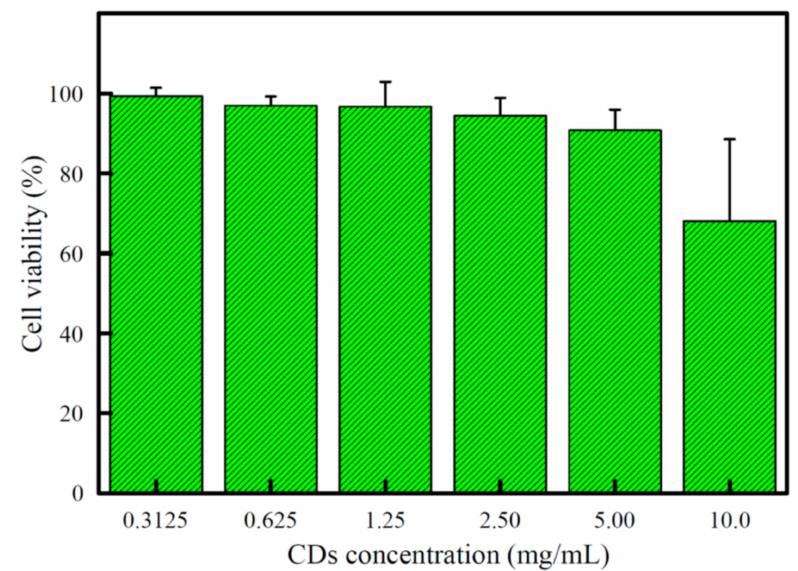
Figure 5. Cell viabili ty of Tramp C1 cells after incubation with di ff erent concentrations of CDs for 24 h.